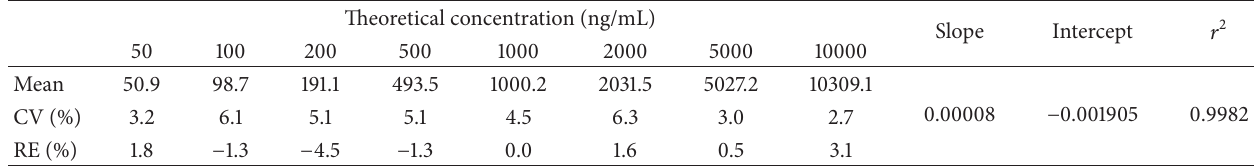
Table 1: Calculated concentrations of PD in calibration standards prepared in rat plasma ( 𝑛 = 5 at each level). Theoretical concentration (ng/mL)